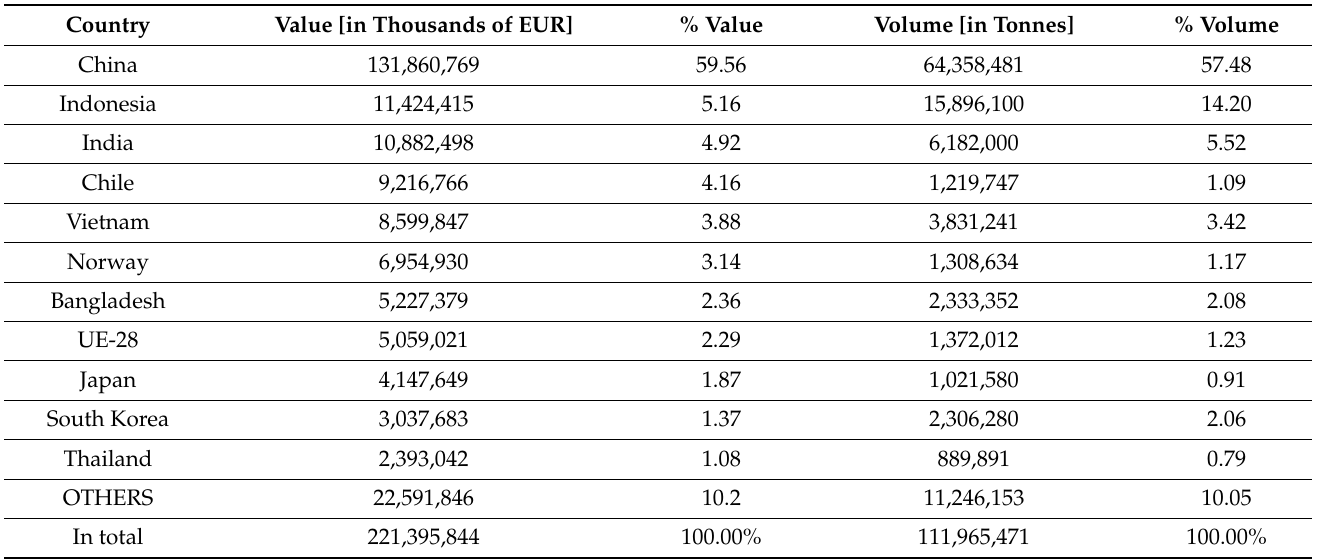
Table 1. Total aquaculture production by major producers in 2017.